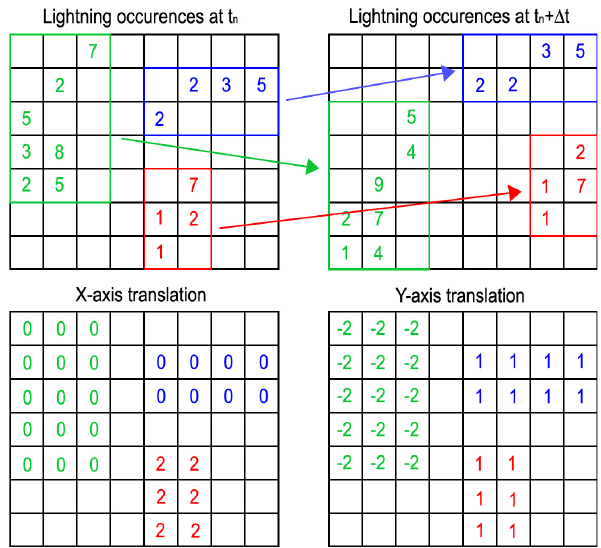
Fig. 2. Schematic of the Lightning-based Precipitation Evolving Technique (L-PET).